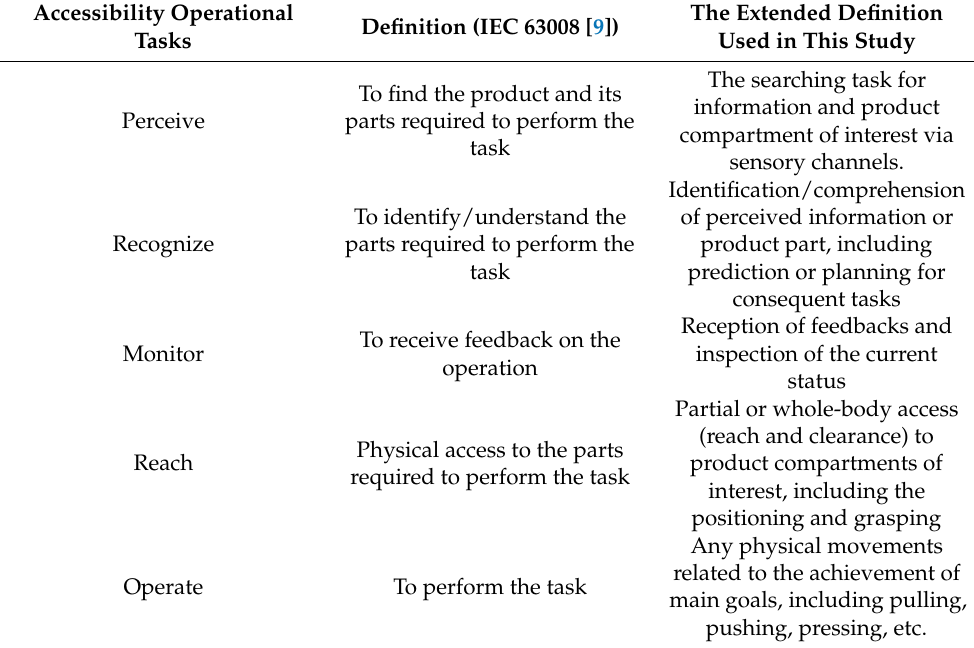
Table 2. Definition of accessibility operational